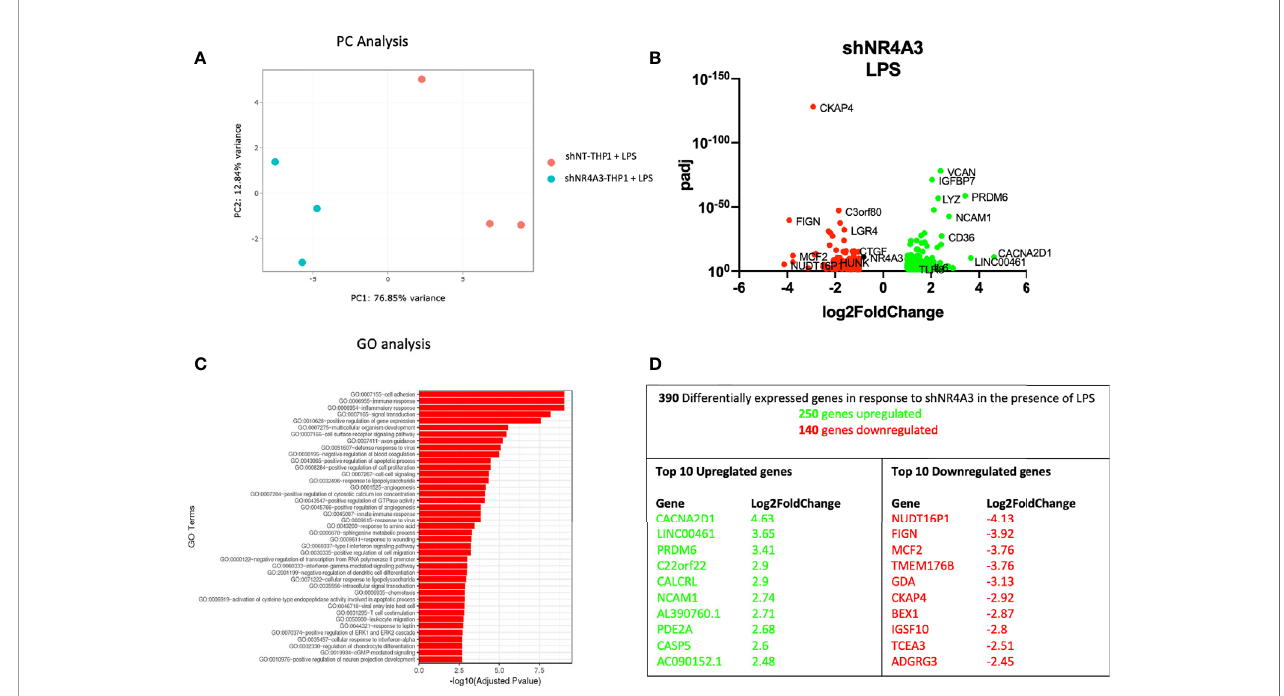
FIGURE 4 | Knockdown of NR4A3 has a distinct transcriptional pro fi le in the presence of LPS. Principal component analysis (PCA) plot of transduced cells based on RNA-seq data between shNT and shNR4A3 in the presence of LPS cells (A) . Volcano plot of signi fi cant DEGs (p<0.05) upregulated (log2fc>/=1) (green) or downregulated (log2fc</=-1) (red) by knockdown of NR4A3 in THP-1 cells in the presence of LPS based on RNA-seq data (B) . Top gene ontology (GO) terms associated with knockdown of NR4A3 in THP-1 cells in the presence of LPS based on RNA-seq data (C) . Summary table of signi fi cant DEGs upregulated (green) and downregulated (red) by knockdown of NR4A3 in THP-1 cells in the presence of LPS based on RNA-seq data (D)